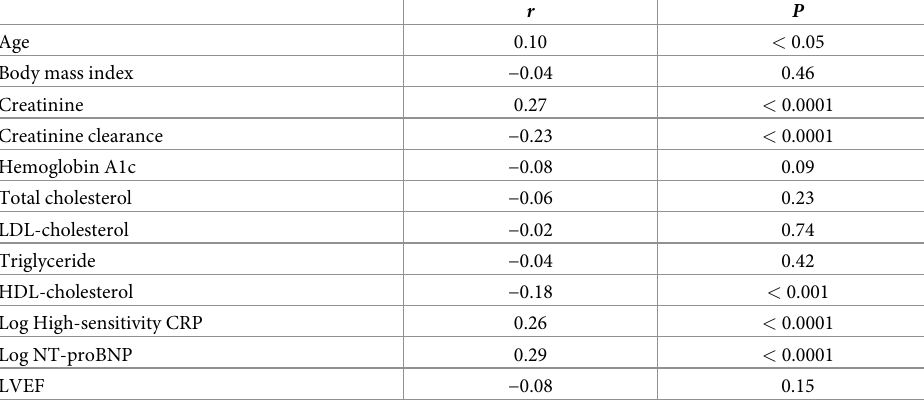
Table 2. Correlations of log FSTL1 and clinical characteristics.